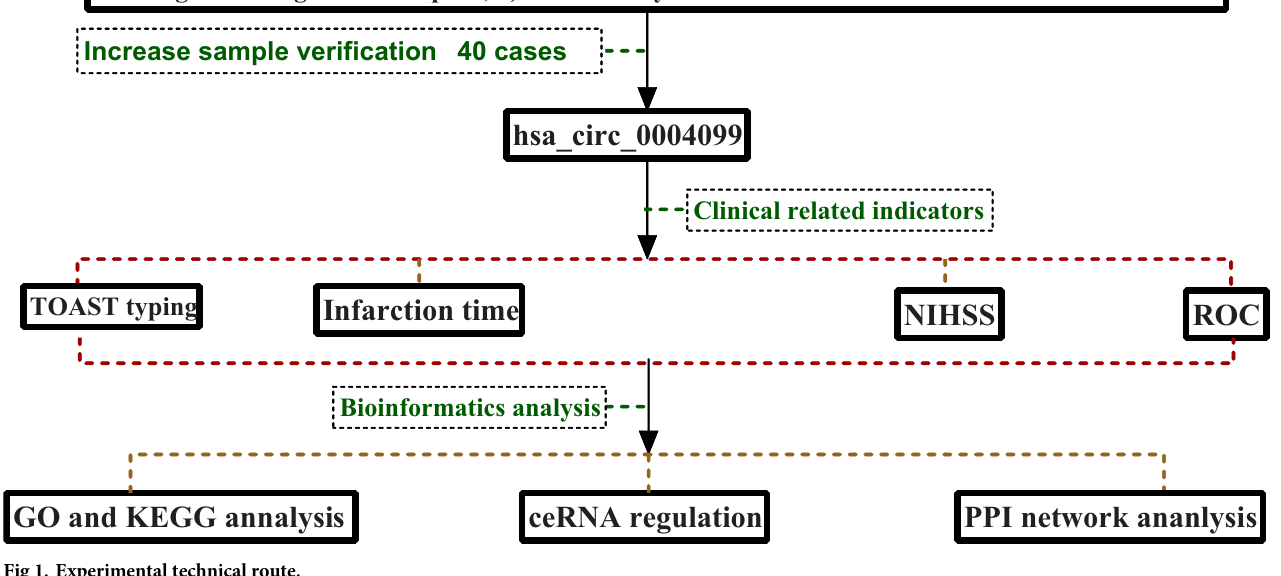
Fig 1. Experimental technical